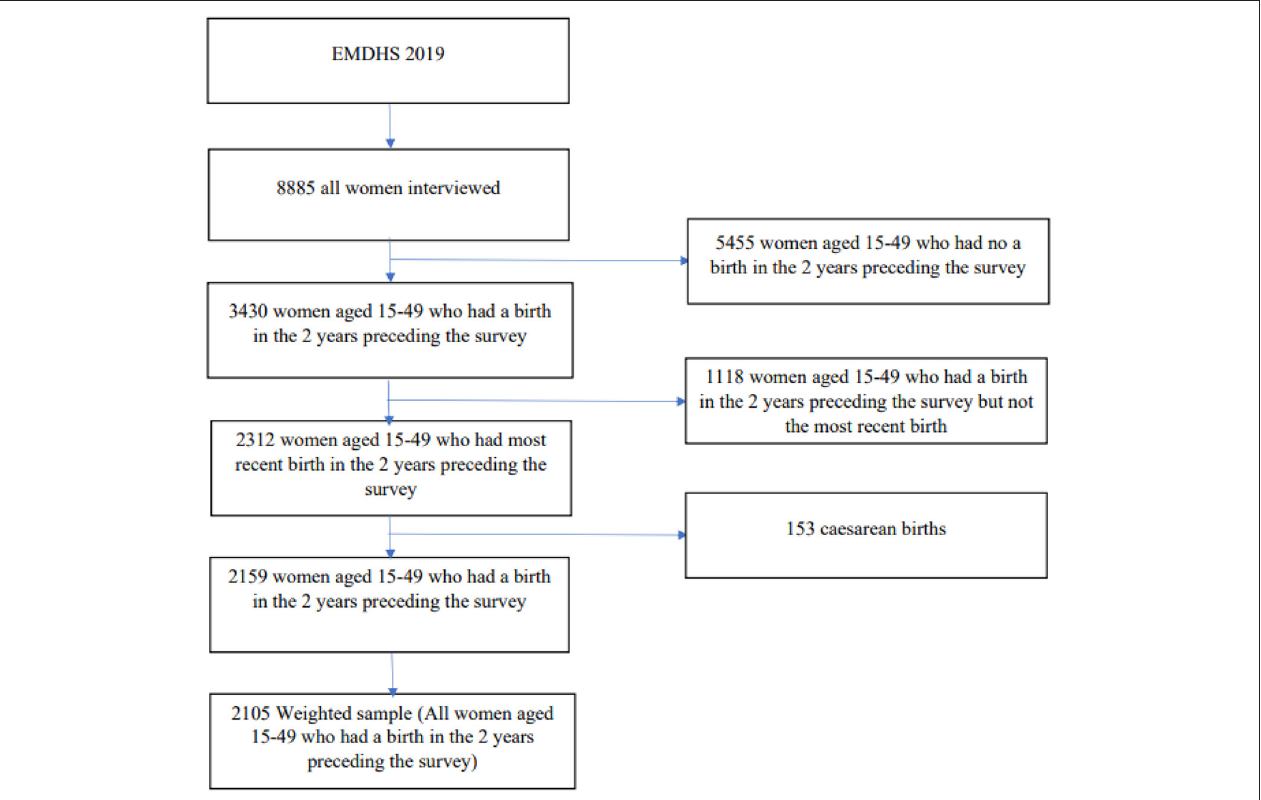
FIGURE 1 | Final sample size and schematic presentation of how the study sample was selected.